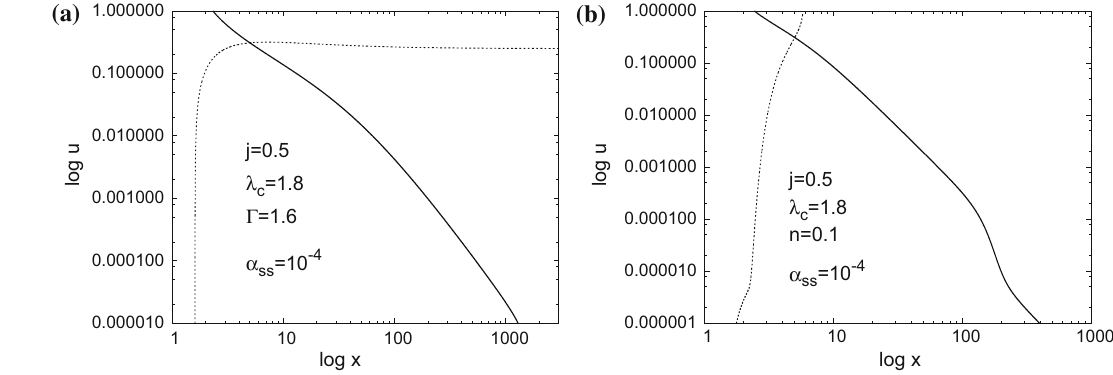
Fig. 5 a , b are plots of log( u ) vs. log( x ) for viscous ( α ss = 10 − 4 ) accretion disc flow around a rotating BH (with specific angular velocity j = 0 . 5) for adiabatic and MCG, respectively. Accretion and wind curves are depicted by solid and dotted lines, respectively